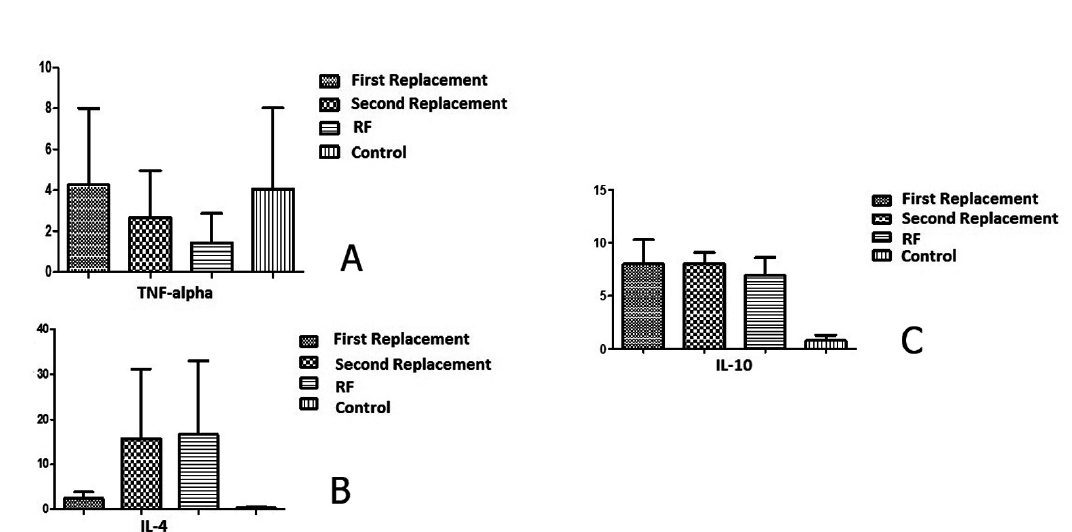
Fig. 2 – Graph showing the mean expression for different interleukins (A: TNF-alpha; B: IL-4 and C: IL-10). Legends- TNF-alpha: Tumor necrosis factor alpha; IL-4: Interleukin-4; IL-10: